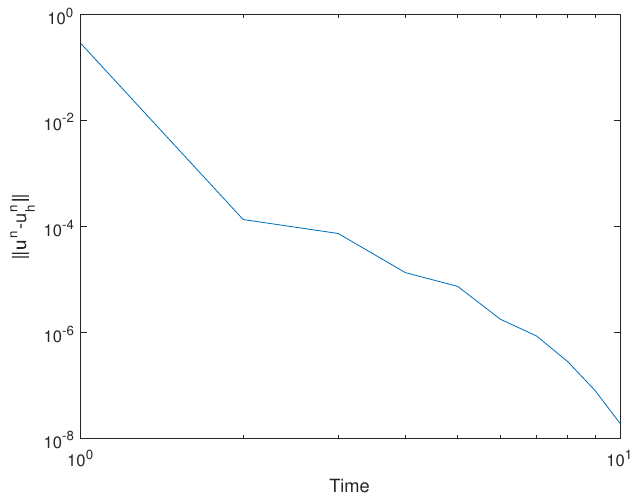
Figure 5. The behavior of the error (cid:107) u n − u n